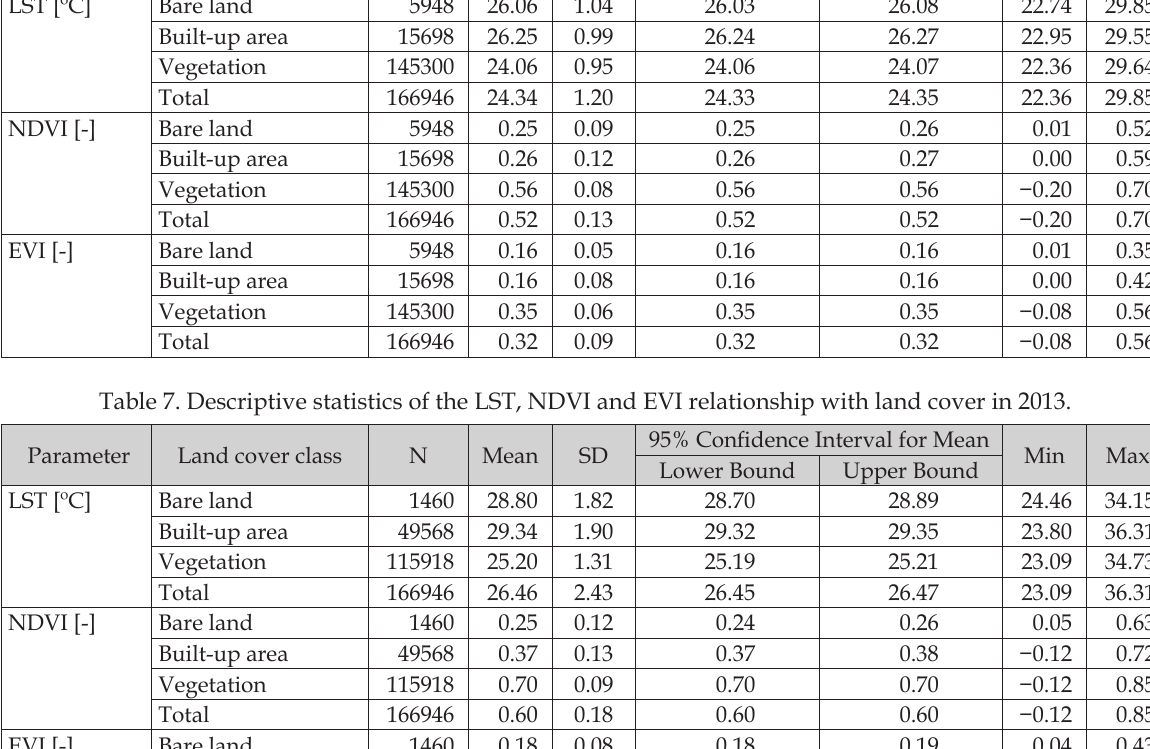
Table 6. Descriptive statistics of the LST, NDVI and EVI relationship with land cover in 2002. Parameter